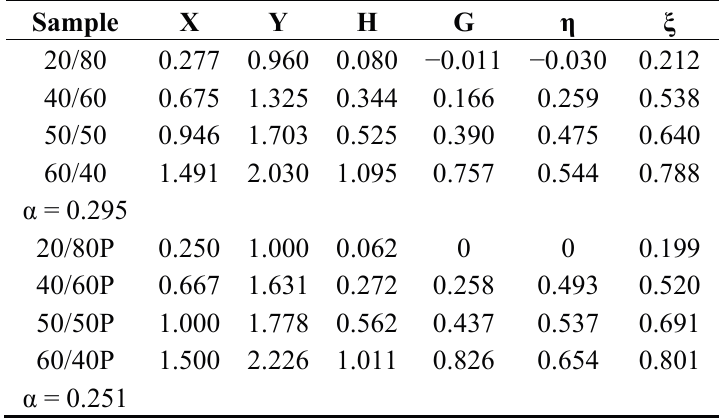
Table 2. Copolymerization data for the